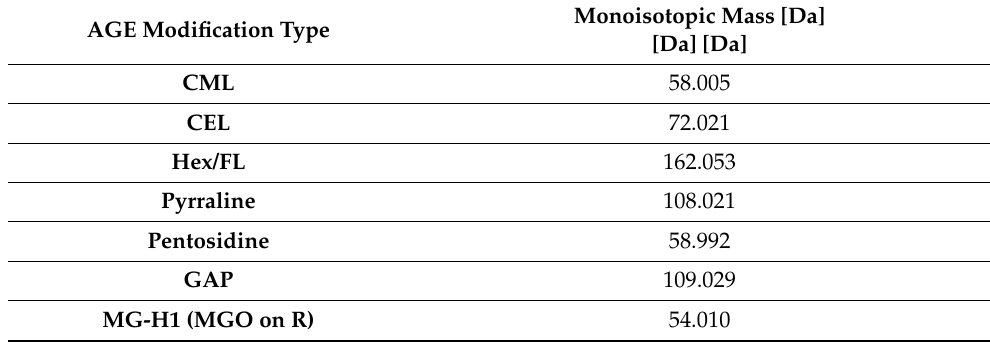
Table 5. AGE modifications considered in the analysis and the corresponding monoisotopic